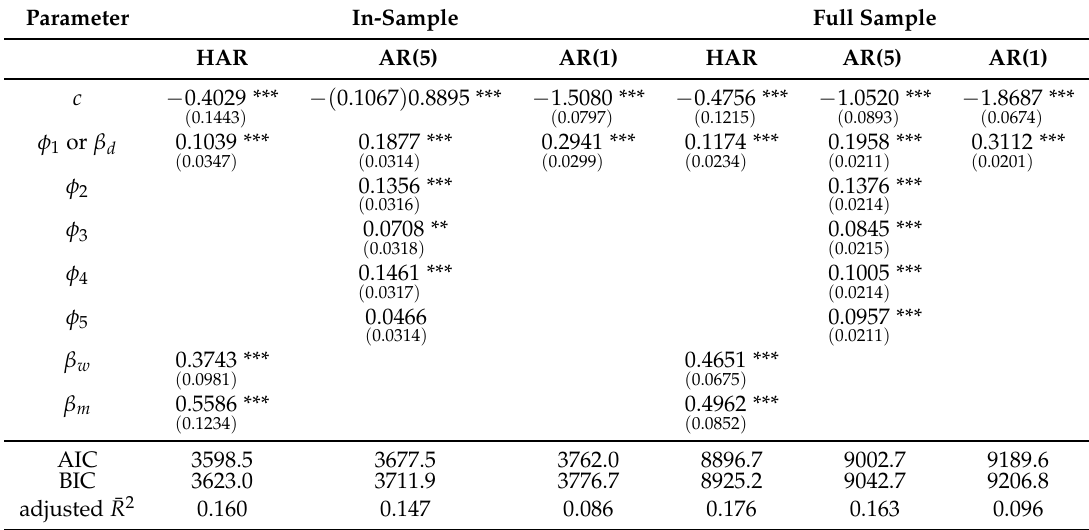
Table 3. Time series model estimates, (cid:98) L t